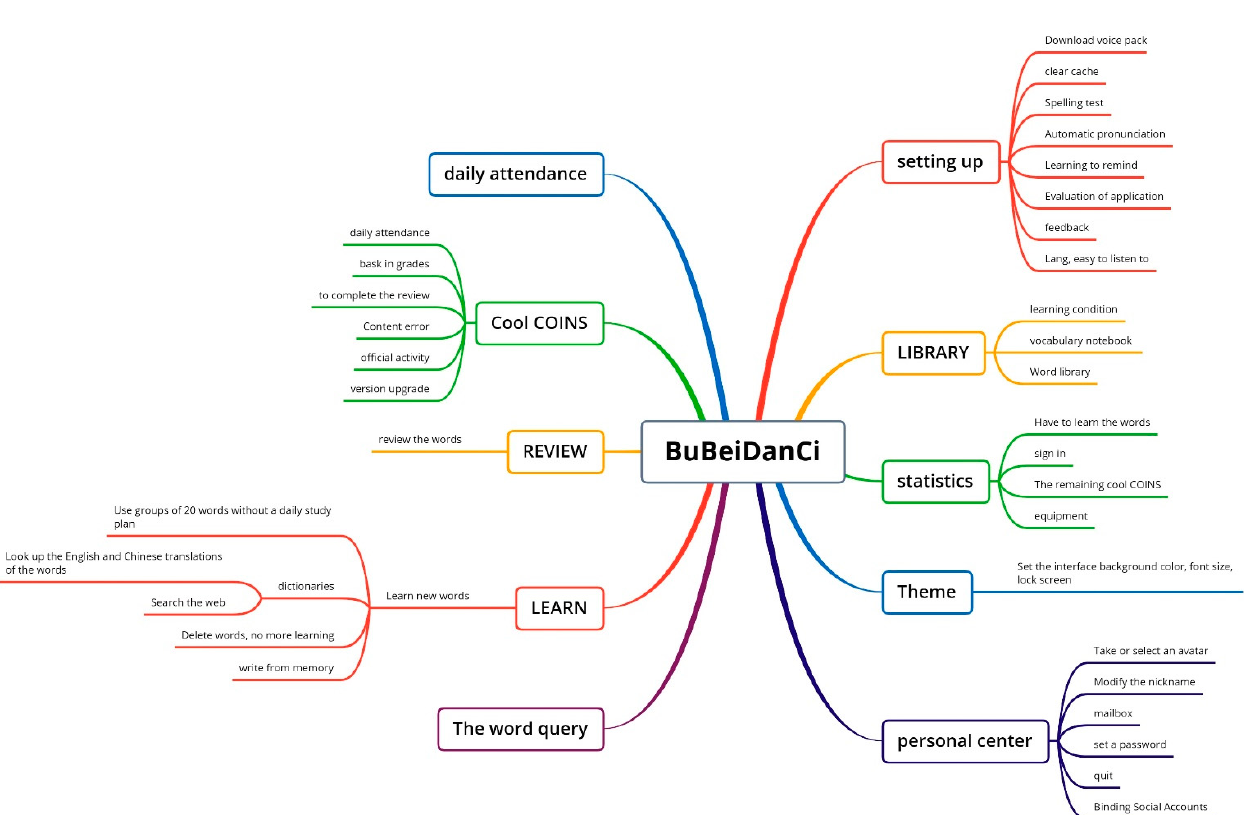
Figure 3. Distribution of BuBeiDanCi APP modules.